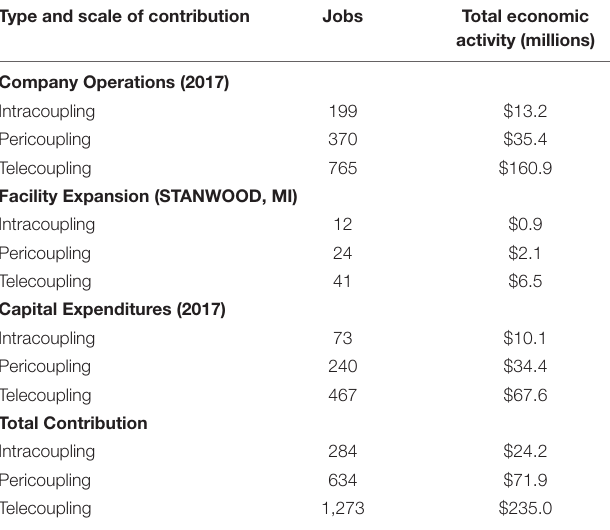
TABLE 2 | Economic contributions of groundwater withdrawal (jobs, total economic activity) at the intracoupling, pericoupling, and telecoupling scales. Type and scale of